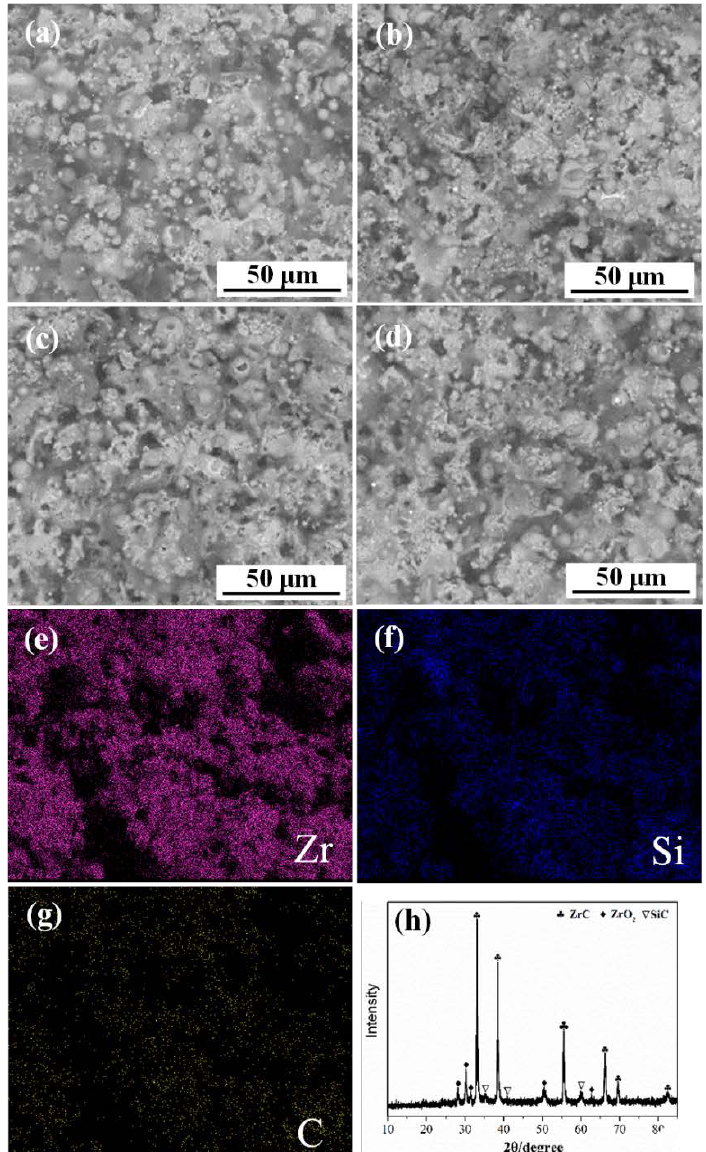
Figure 8. Surface images, elemental mapping and XRD pattern of as-prepared ZrC–SiC layer. ( a ), ( e – h ) S3-A; ( b ) S3-B; ( c ) S3-C; ( d ) S3-D.